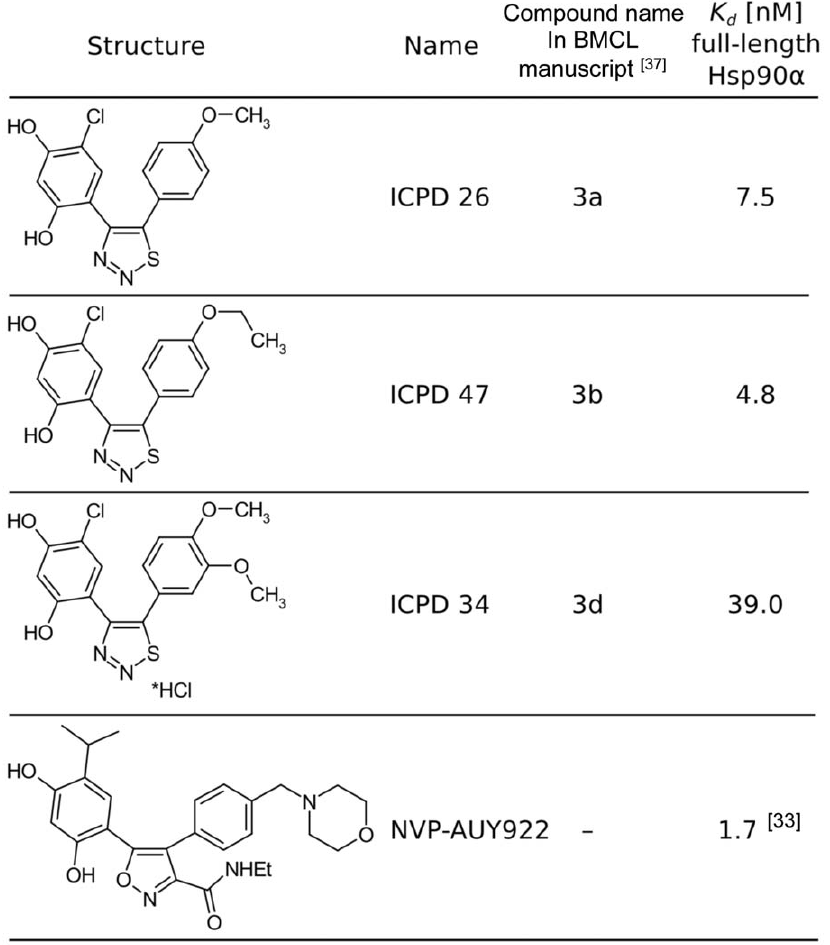
Figure 1. Chemical strucures of the thiadiazole compounds and NVP-AUY922. The K d values for binding to Hsp90 are indicated.